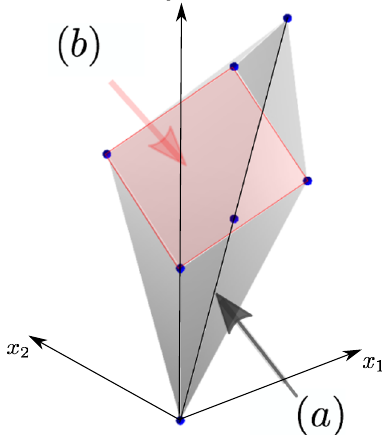
, compare with diag(2 ; 2)